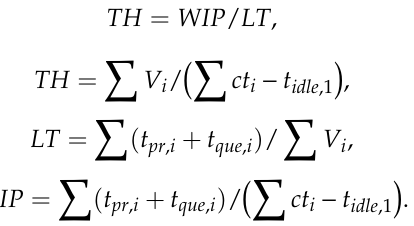
simulation which does not occur idling and queuing times.